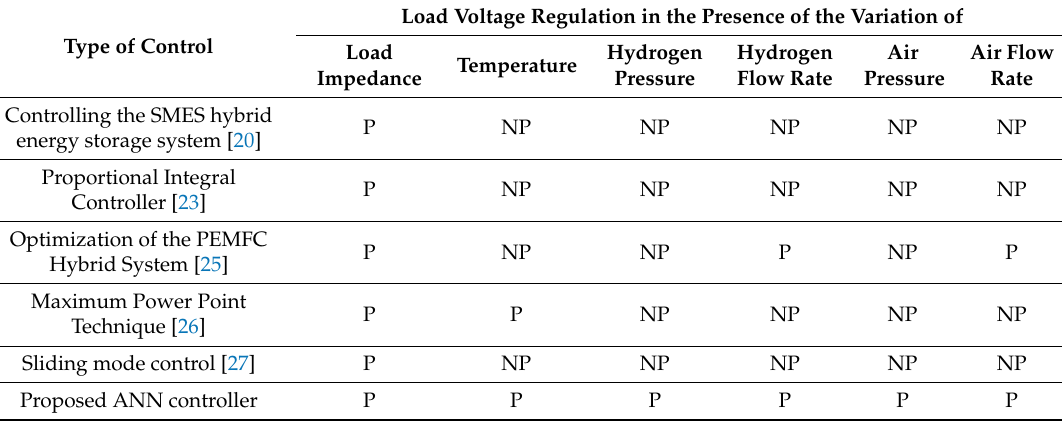
Table 4. Comparison of the proposed controller and proposed techniques in [20,23,25,26] and